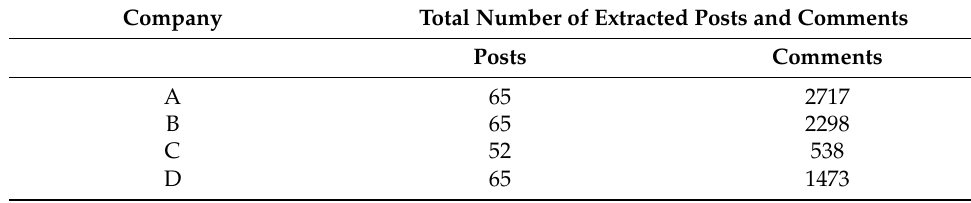
Table 4. Overview of obtained comments.